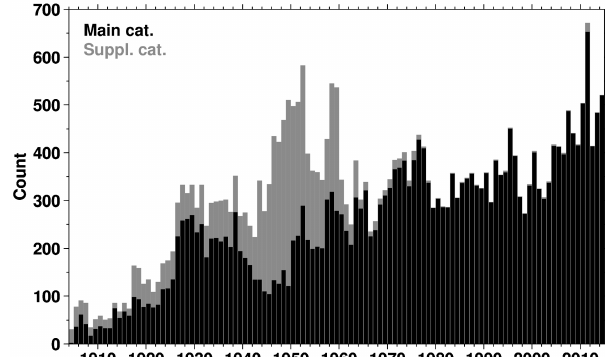
Figure 23. Annual number of earthquakes in the Main (black) and Supplementary (grey) ISC-GEM Catalogue; from the count of the Supplementary catalogue we have excluded a subset of earthquakes with M S below